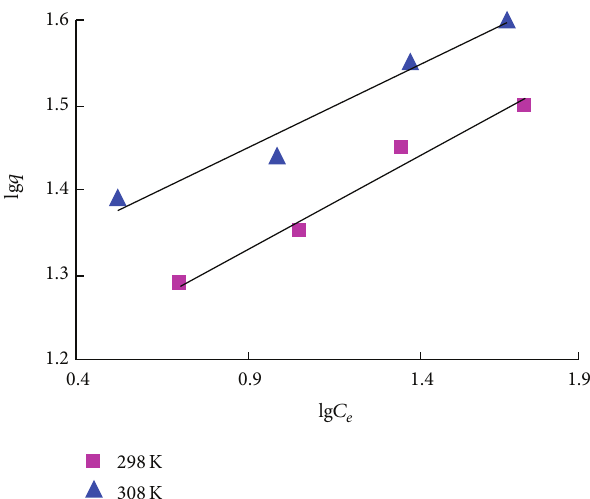
Figure 2: Freundlich adsorption isotherm of Ni(II) by the resin. 0.00.51.01.52.0 Figure 3: The relationship between log (𝑞 𝑒 − 𝑞 𝑡 ) and 𝑡 .